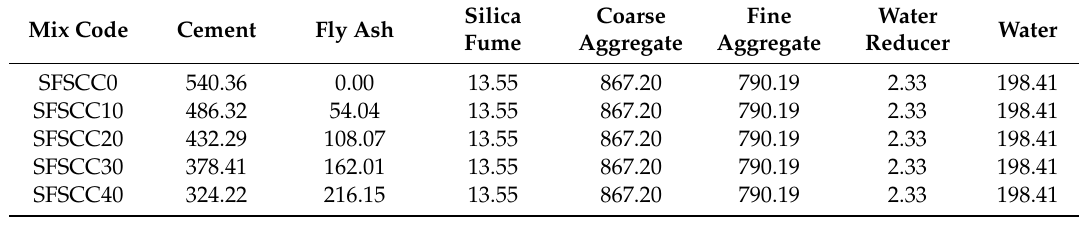
Table 6. Mix Proportion of SCC (kg/m 3 ).